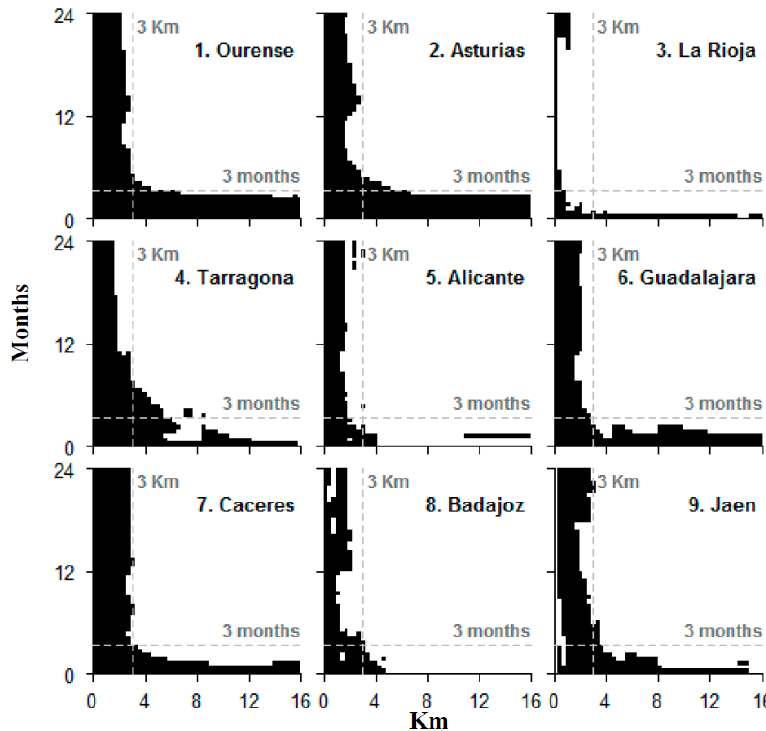
Figure 5. Comparison between ˆ K st ( u , v ) − 2 π u 2 v and tolerance envelopes indicating spatio-temporal clustering (black values) for each study area. Reference of 3 km and three months in grey dotted line.